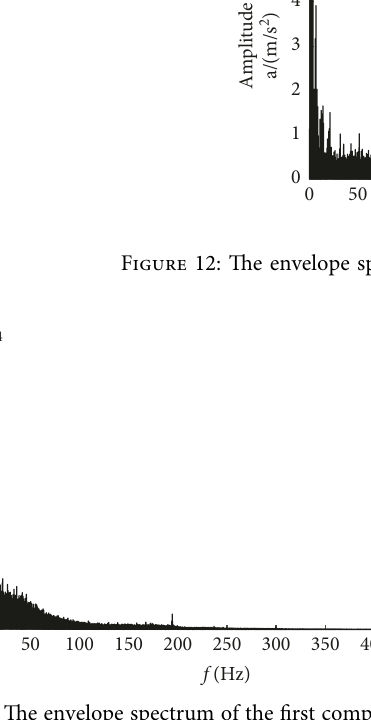
Figure 15: The envelope spectrum of the first component derived from VMD decomposition of a vibration signal from class 3.